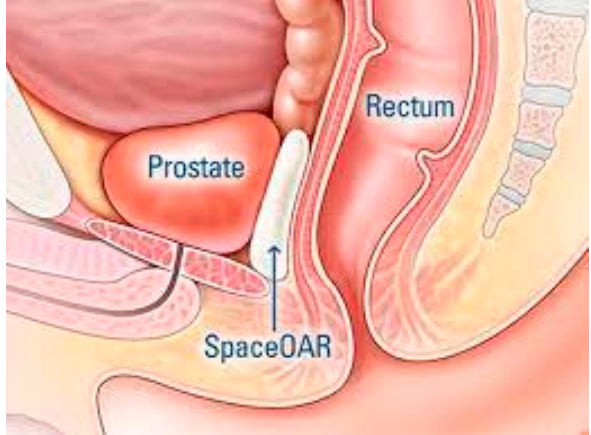
Figure 2. SpaceOAR™ Hydrogel is an absorbable injectable material designed to provide space between the prostate and rectum in men undergoing radiotherapy for pelvic cancers (reproduced from Boston Scientific, Marlborough, MA, USA).